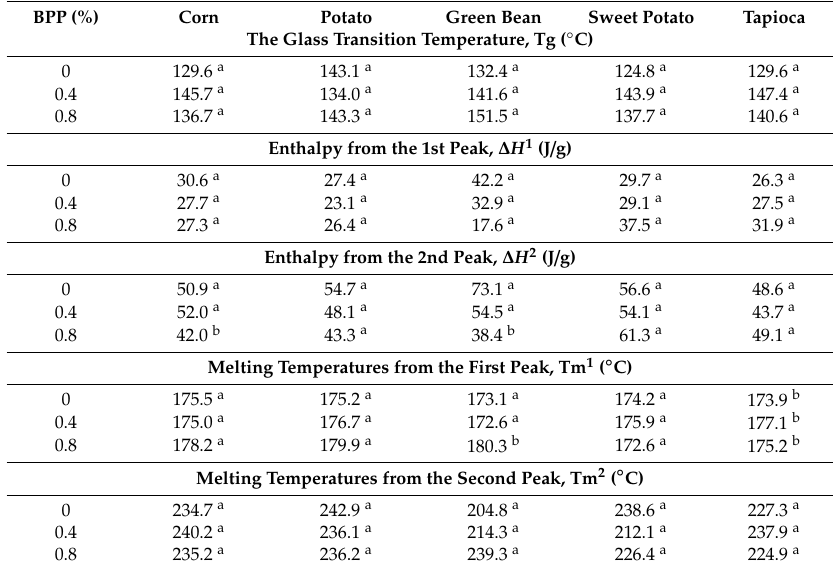
Table 5. The thermal properties of all the films measured using DSC data analysis.